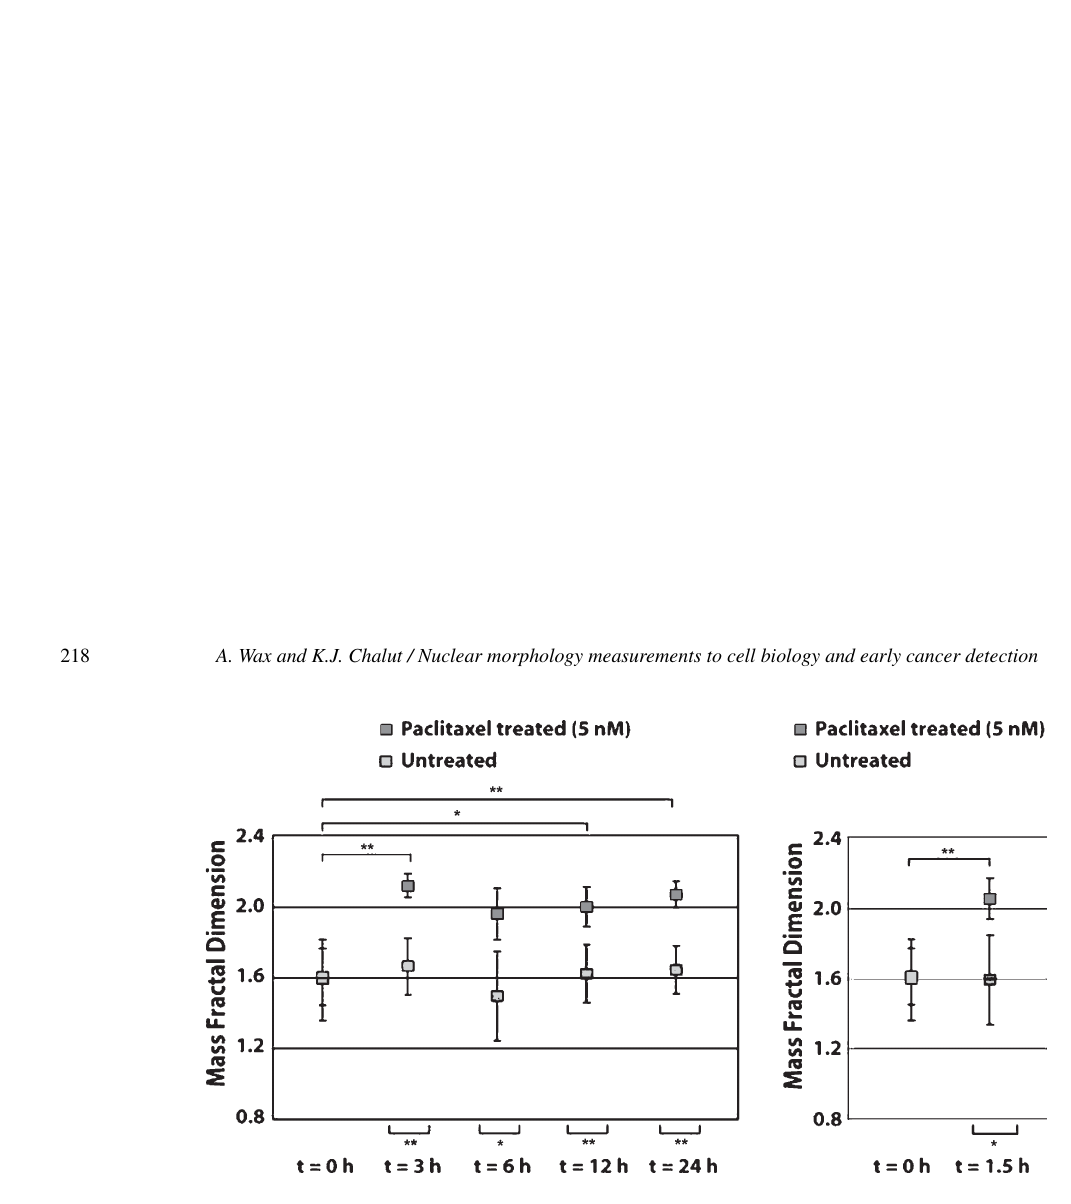
Fig. 13. Fractal dimenstion of MCF-7 cells shows a significant change in response to 5nM treatment with Paclitaxel at t =3, 6, 12 and 24h post treatment. (Right) Comparison of cells treated with 5nM Paclitaxel and controls at t =1.5h. *indicates statistical significance ( p <0.05) and **indicates high statistical significance ( p <0.001). Adapted from [45]. fractal dimension of D = 2.05 ± 0.20 compared with D = 1.59 ± 0.26 for the control cells, a statistically sig- nificant difference ( p <